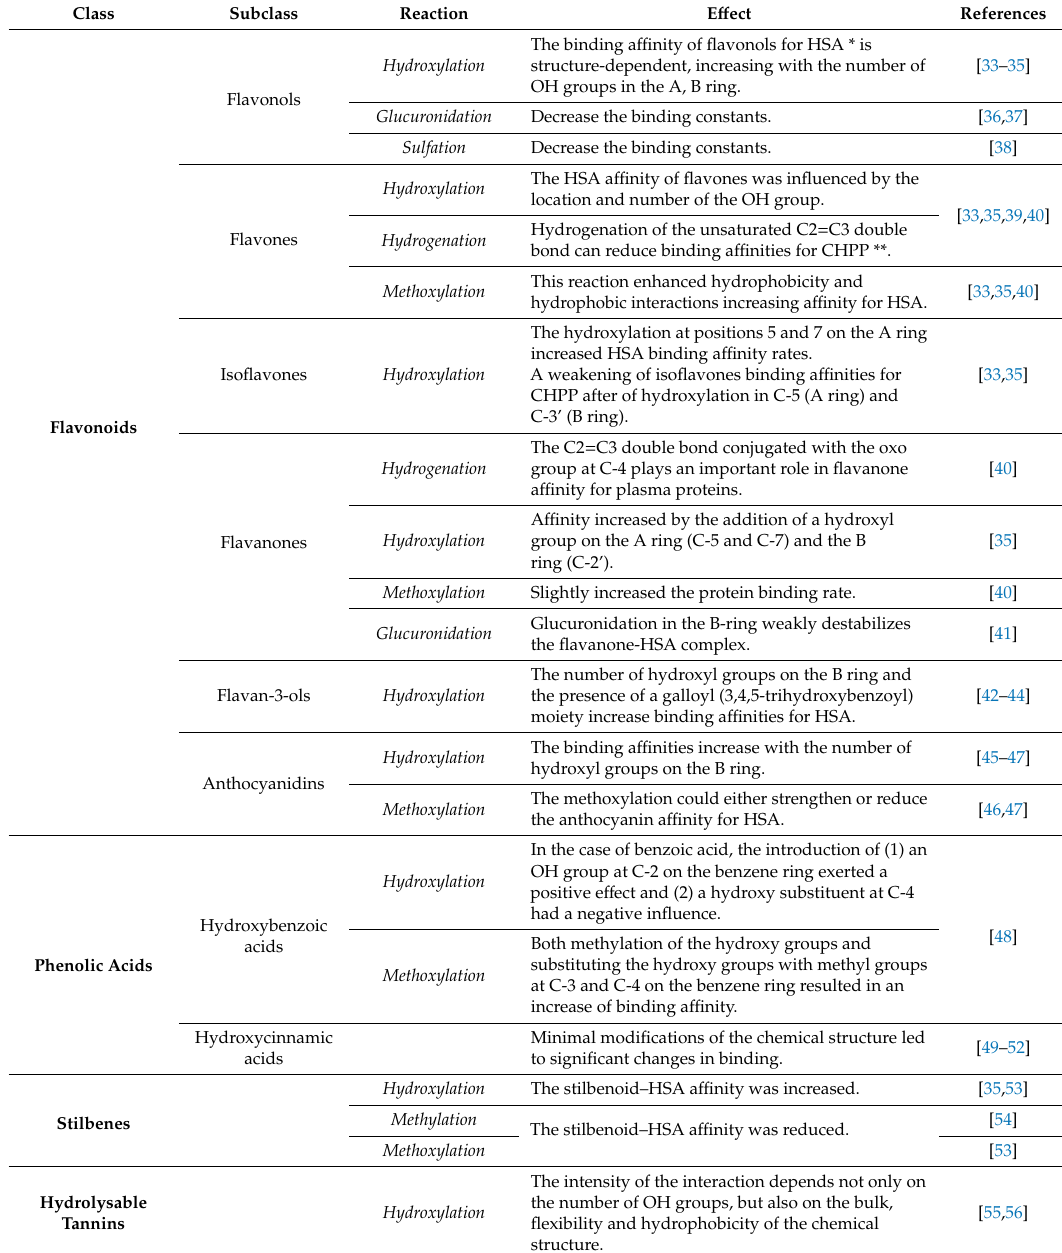
Table 1. Main e ff ect of first pass metabolism of dietary phenolic compounds in human serum albumin (HSA)